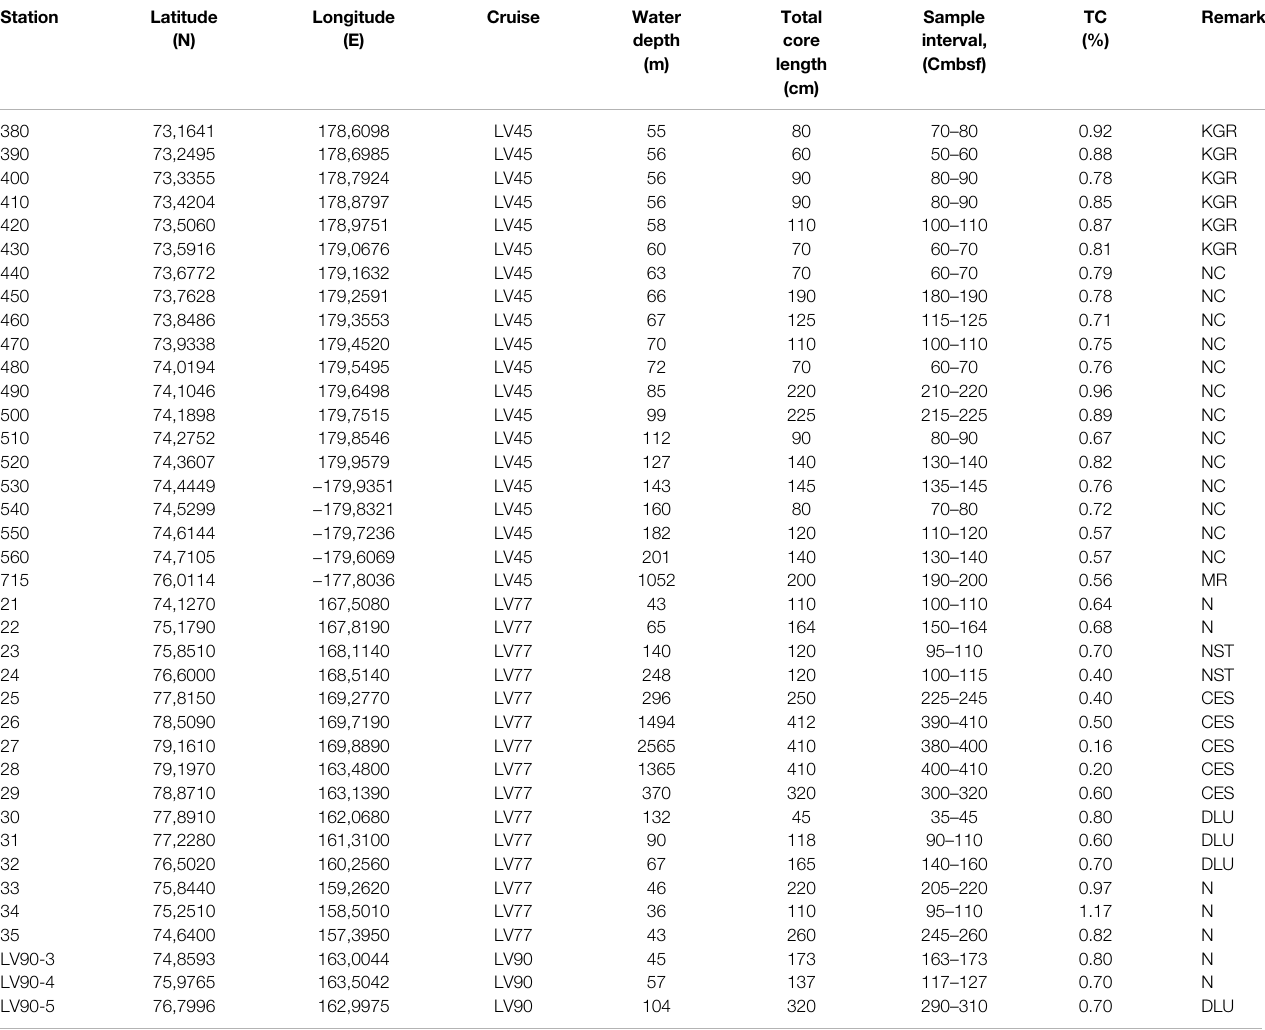
TABLE 1 | General information about the research